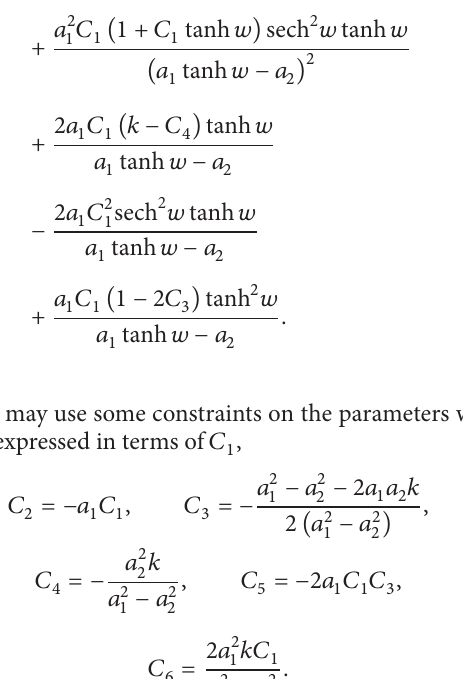
remains nearly constant. The scalar component of the vector potential eff ,1